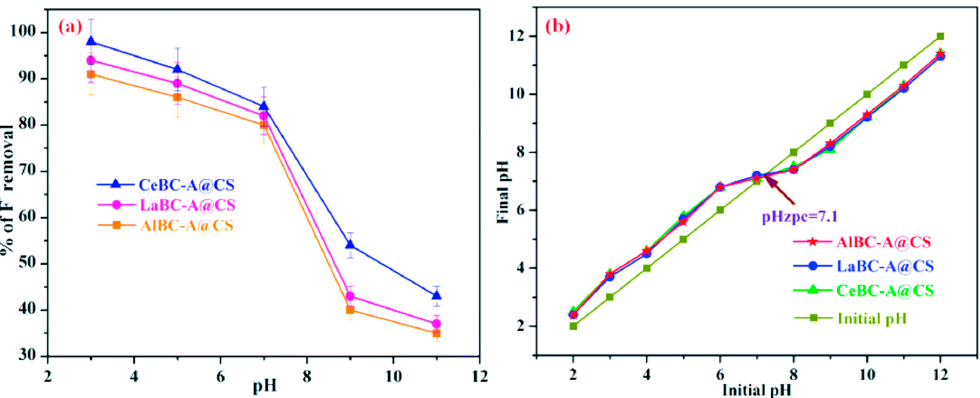
Figure 15. ( a ) Effect of pH and ( b ) pHzpc values of cerium bentonite clay-malic acid chitosan